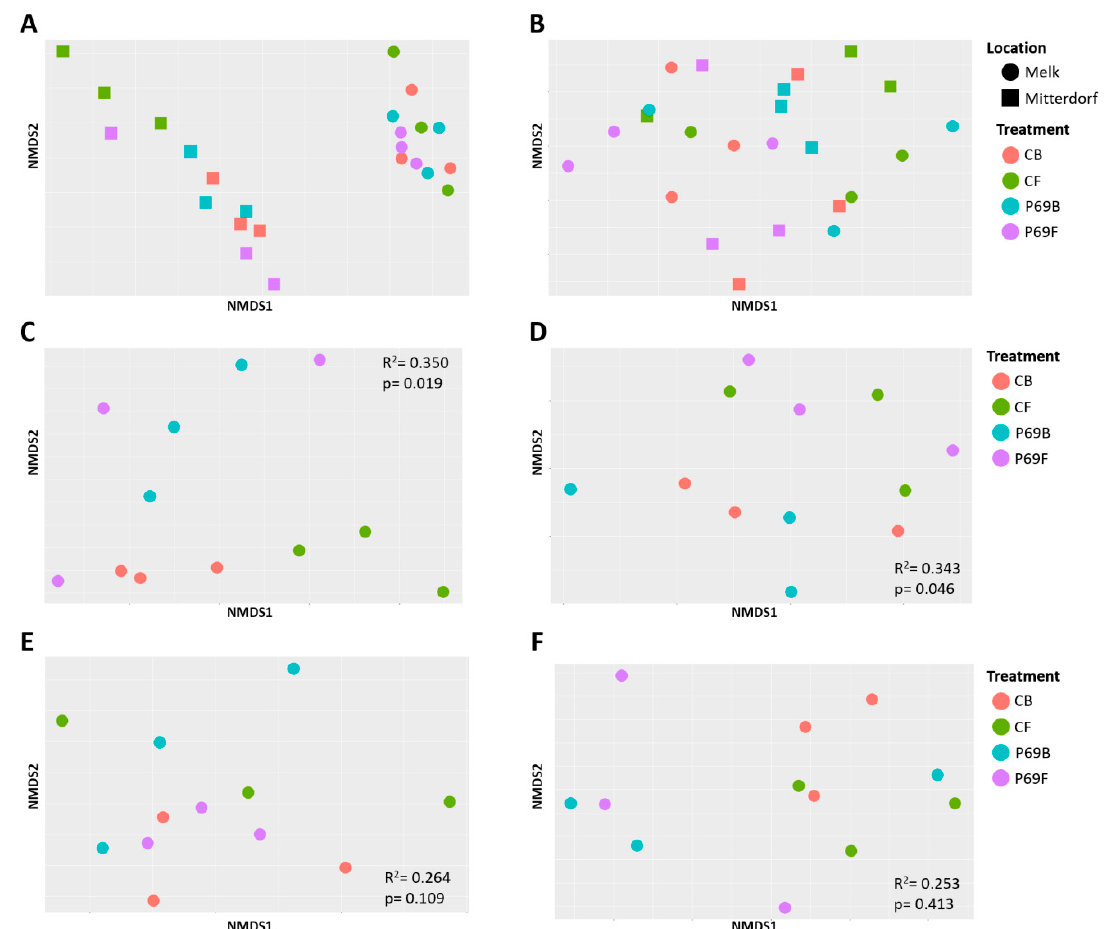
Figure 3. Beta diversity observed for bacterial ( A,C,E ) and fungal ( B,D,F ) communities in treated rhizospheres overall ( A,B ) and for the locations Mitterdorf ( C,D ) and Melk ( E,F ). Beta diversity is shown as non-metric multidimensional scaling (NMDS) of Bray–Curtis dissimilarity measures. Significance was tested using